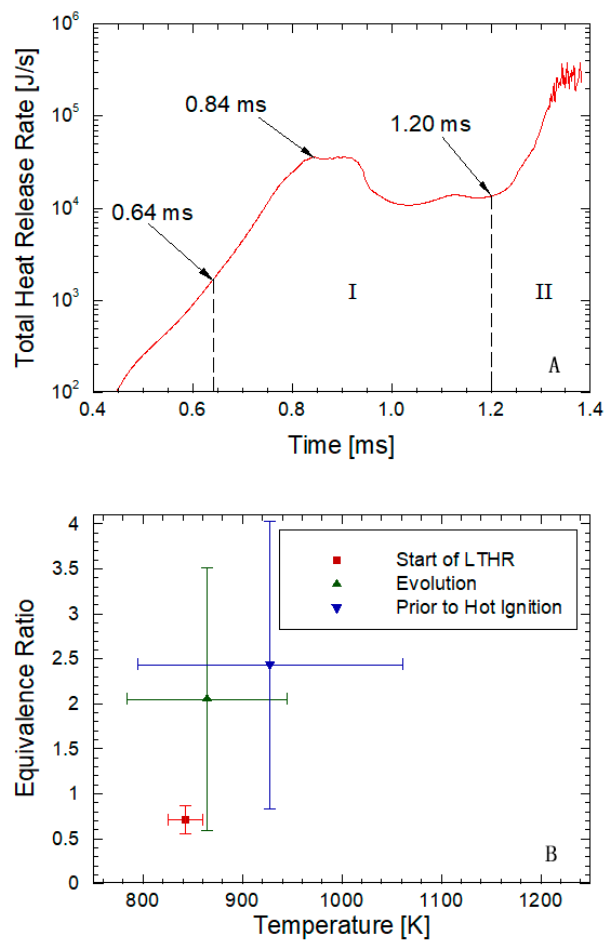
Figure 3. Schematic representation of the evolution of the total HRR ( A ) and the exothermic region ( B ) at an initial temperature of 850 K with Wang et al. [39] Mechanism.